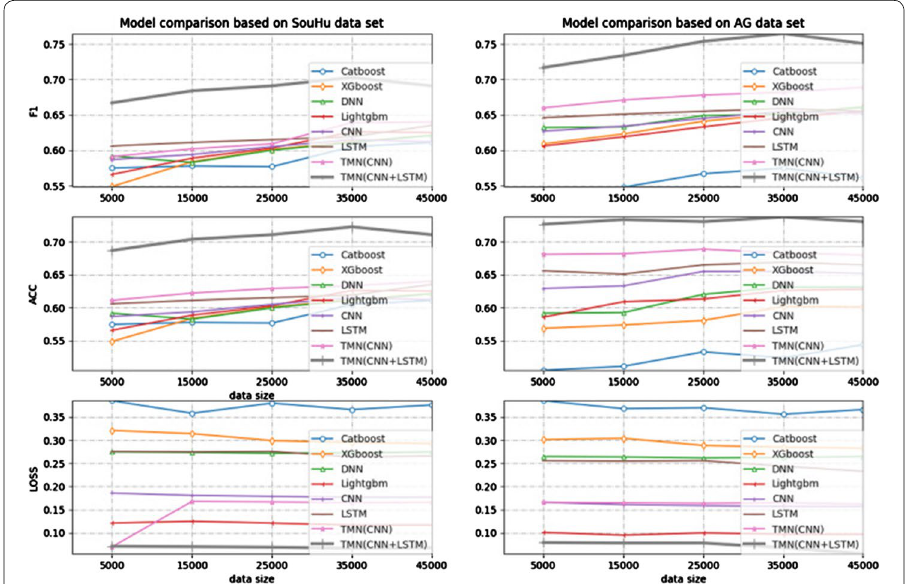
Fig. 9 Image from [102] illustrating neural network based algorithms outperforming Gradient Boosted tree algorithms for classifying homogeneous text data in the SoHu dataset of news articles labeled as with or without marketing